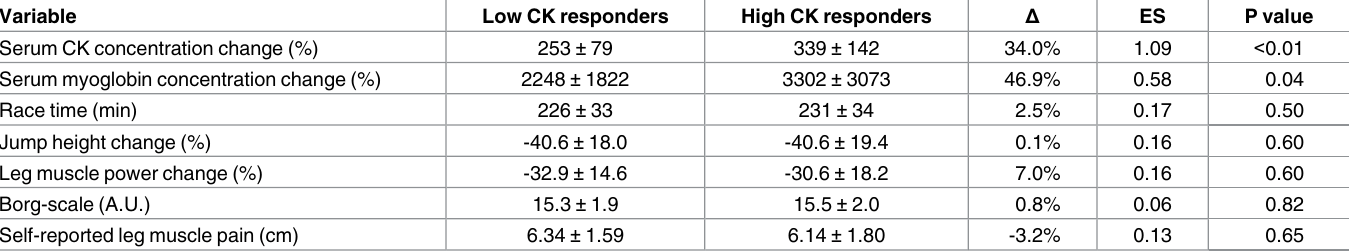
Table 3. Pre-to-post-race changes in serum CK, myoglobin concentration and jump height, race time and self-reported fatigue and muscle pain of runners with low and high CK responses after a marathon. Data are mean ± SD.